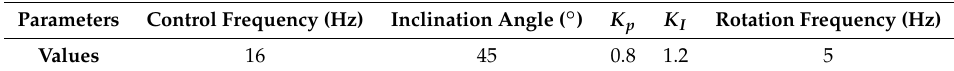
Table 1. Parameters in the